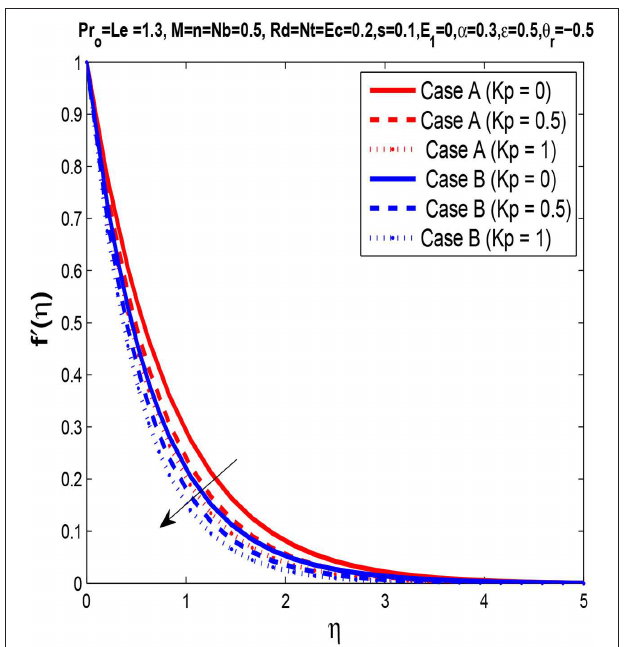
FIGURE 3 | Velocity f ′ ( η ) for different values of Kp .